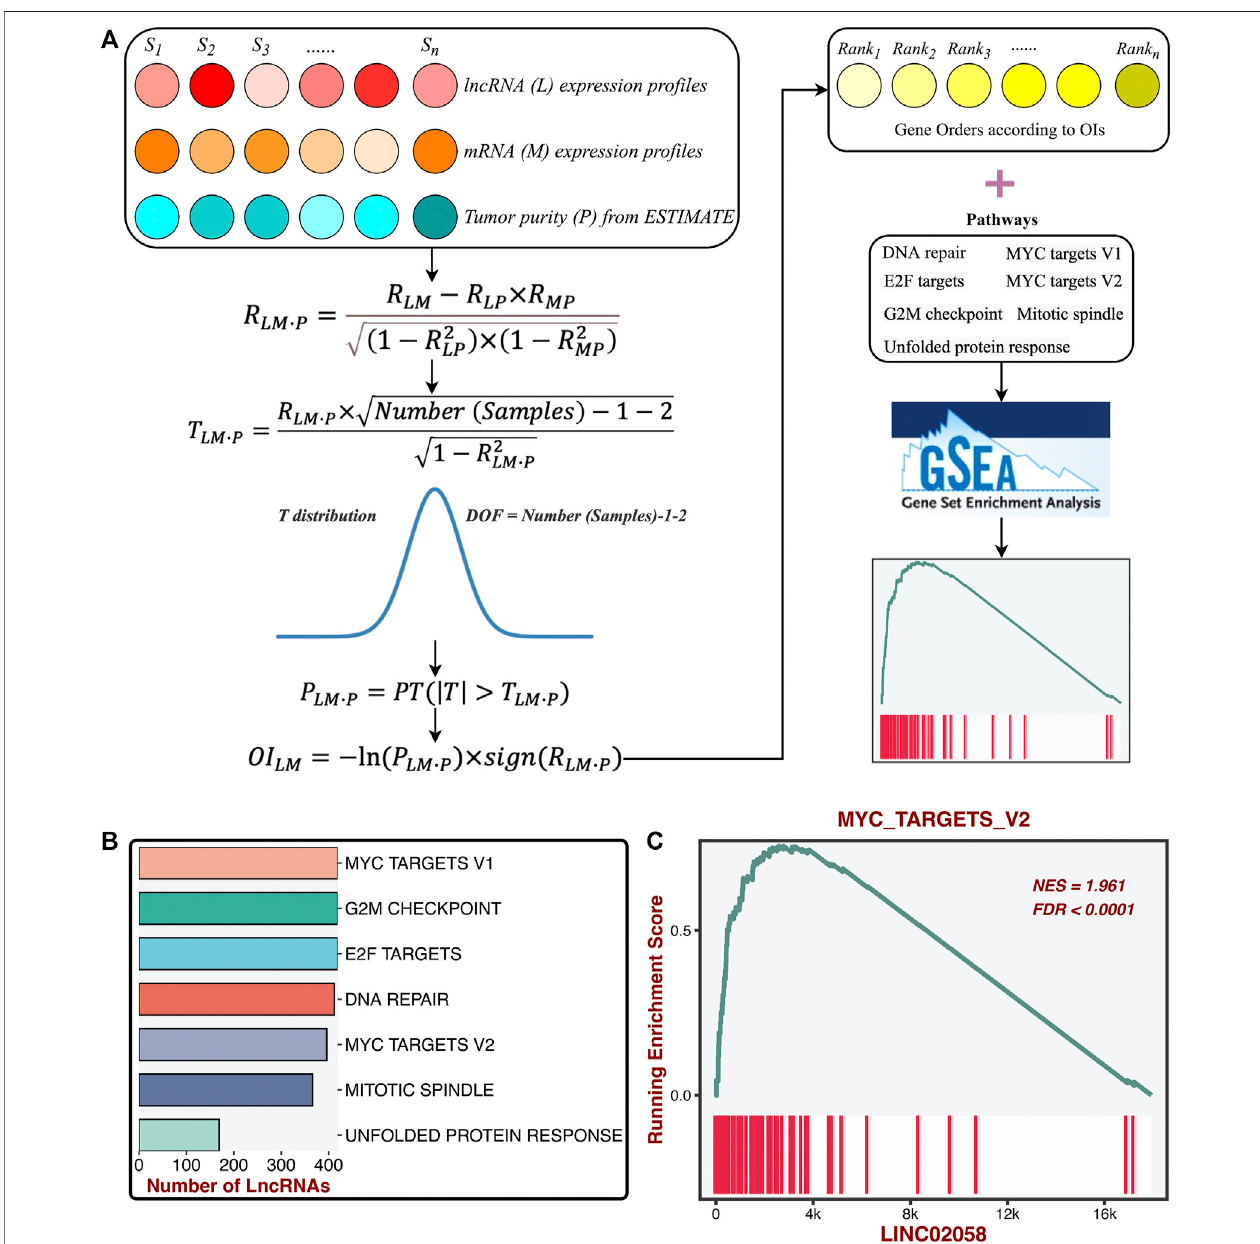
FIGURE 5 | Identi fi cation of the latent lncRNA modulators of proliferation pathways. (A) ProLnc: recognizing the latent lncRNA modulators of proliferation pathways. (B) The number of lncRNAs signi fi cantly associated with proliferation pathways. (C) LINC02058 was dramatically associated with MYC targets V2.